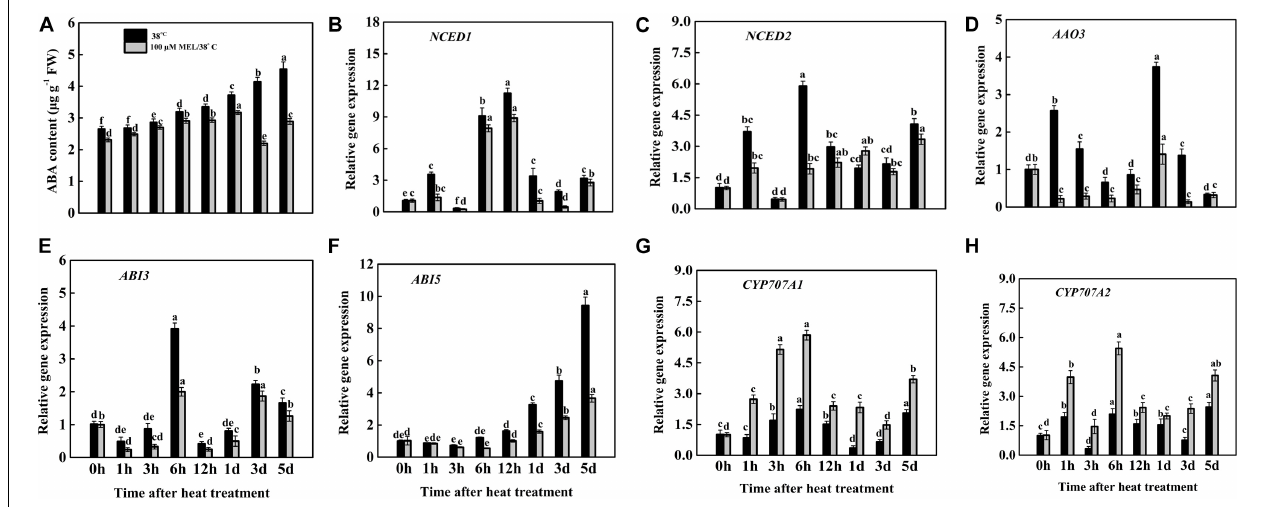
FIGURE 5 | Effects of exogenous melatonin treatment on the (A) endogenous ABA content and (B–D) transcript abundance of ABA biosynthesis genes ( NCED1, NCED2, and AAO3 ), (E,F) ABA signaling genes ( ABI3 and ABI5 ), (G,H) ABA of catabolic genes ( CYP707A1, and CYP707A2 ) during heat stress with or without of melatonin treatment. Different letters denote the significant variations between the treatments and the average values were measured by Tukey’s Honestly Significant Difference (HSD) test at P < 0.05. Data represented as the mean ± standard error of triplicate biological